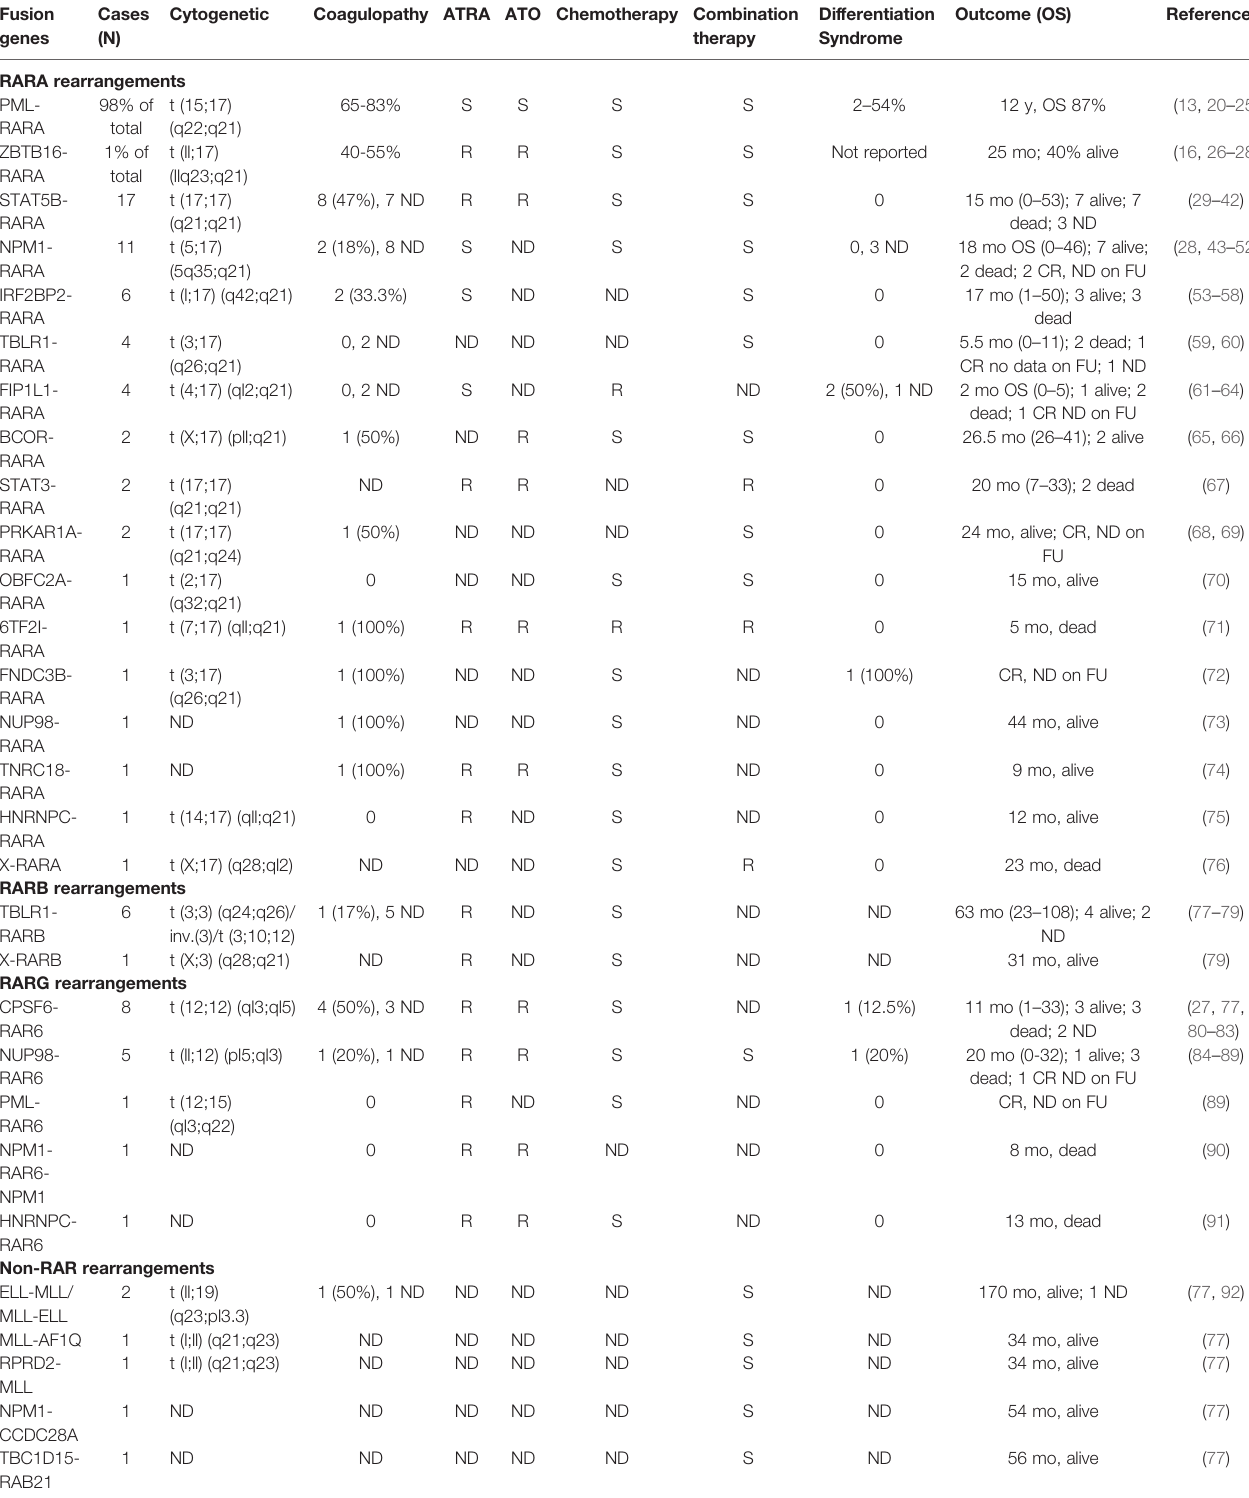
TABLE 1 | Genetic, clinical, and prognostic features of variant and acute promyelocytic leukemias. Fusion